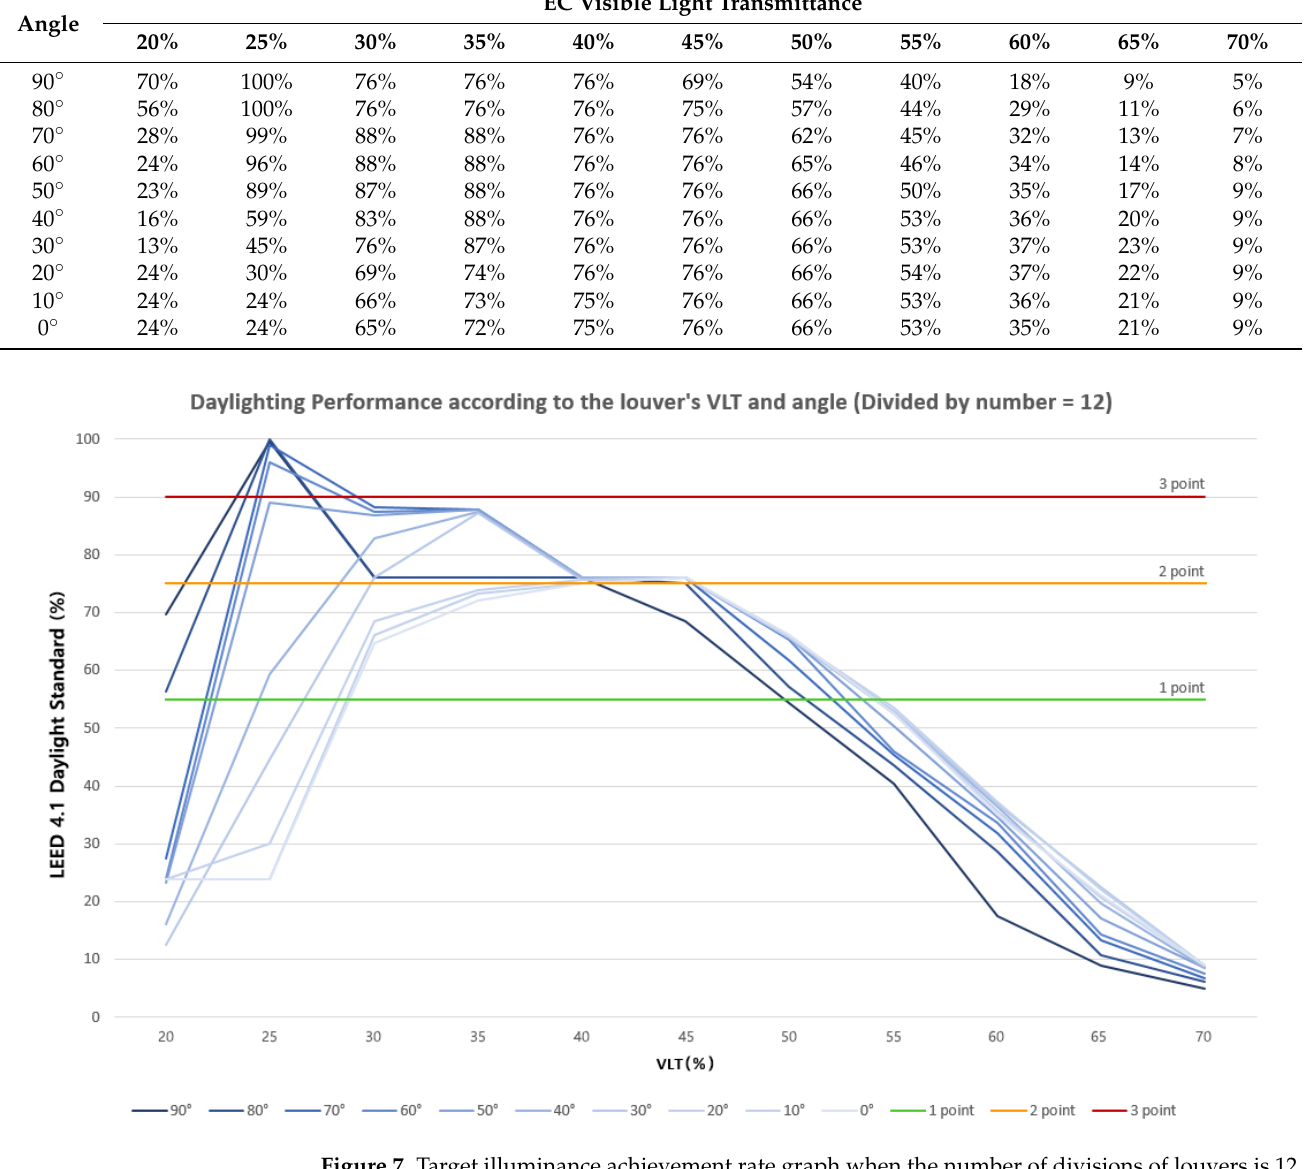
Table 7. Target illuminance achievement rates when the number of divisions of louvers is 13.